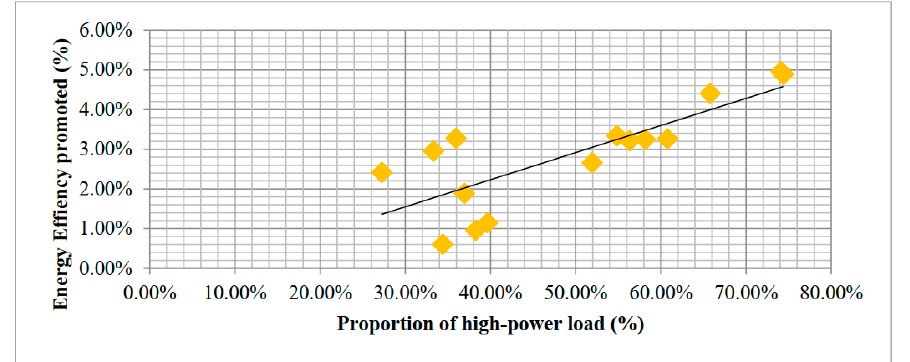
Figure 12. Correlation comparison between the proportion of photovoltaic output and energy efficiency improvement in 15 scenarios.